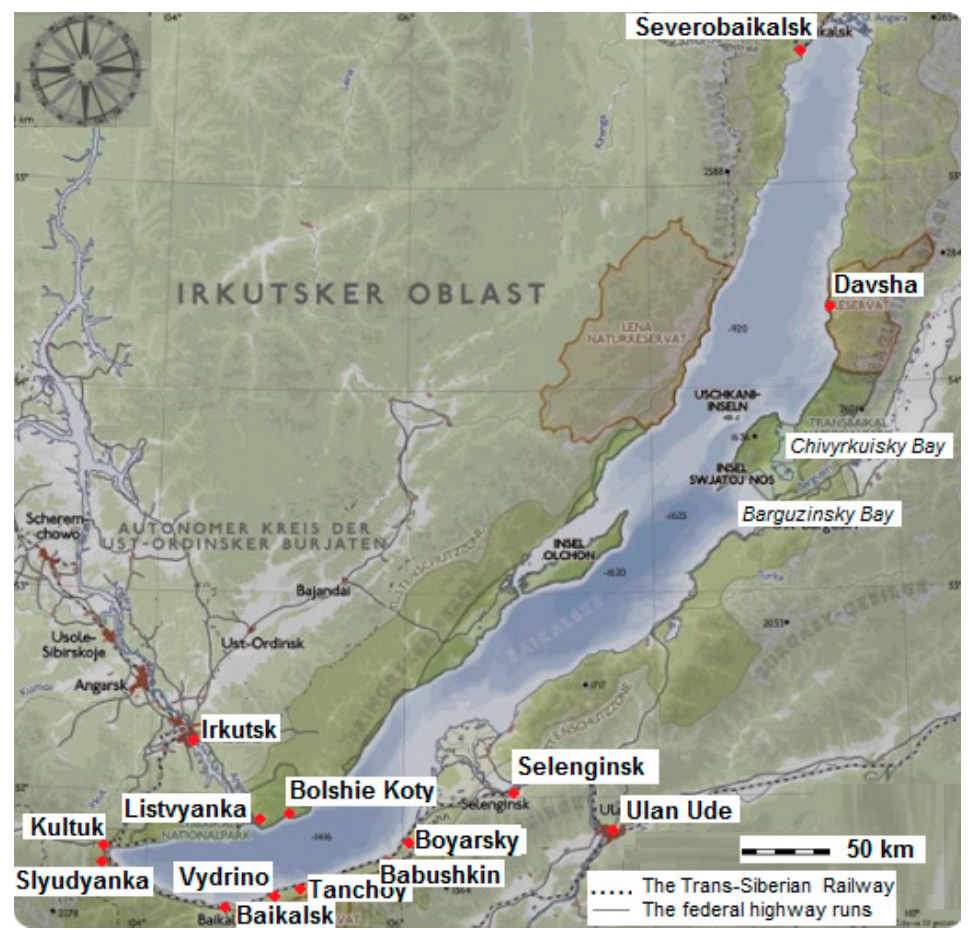
Figure 1. Layout of settlements, the Trans-Siberian Railway and the federal highway in the Southern Baikal region [10].